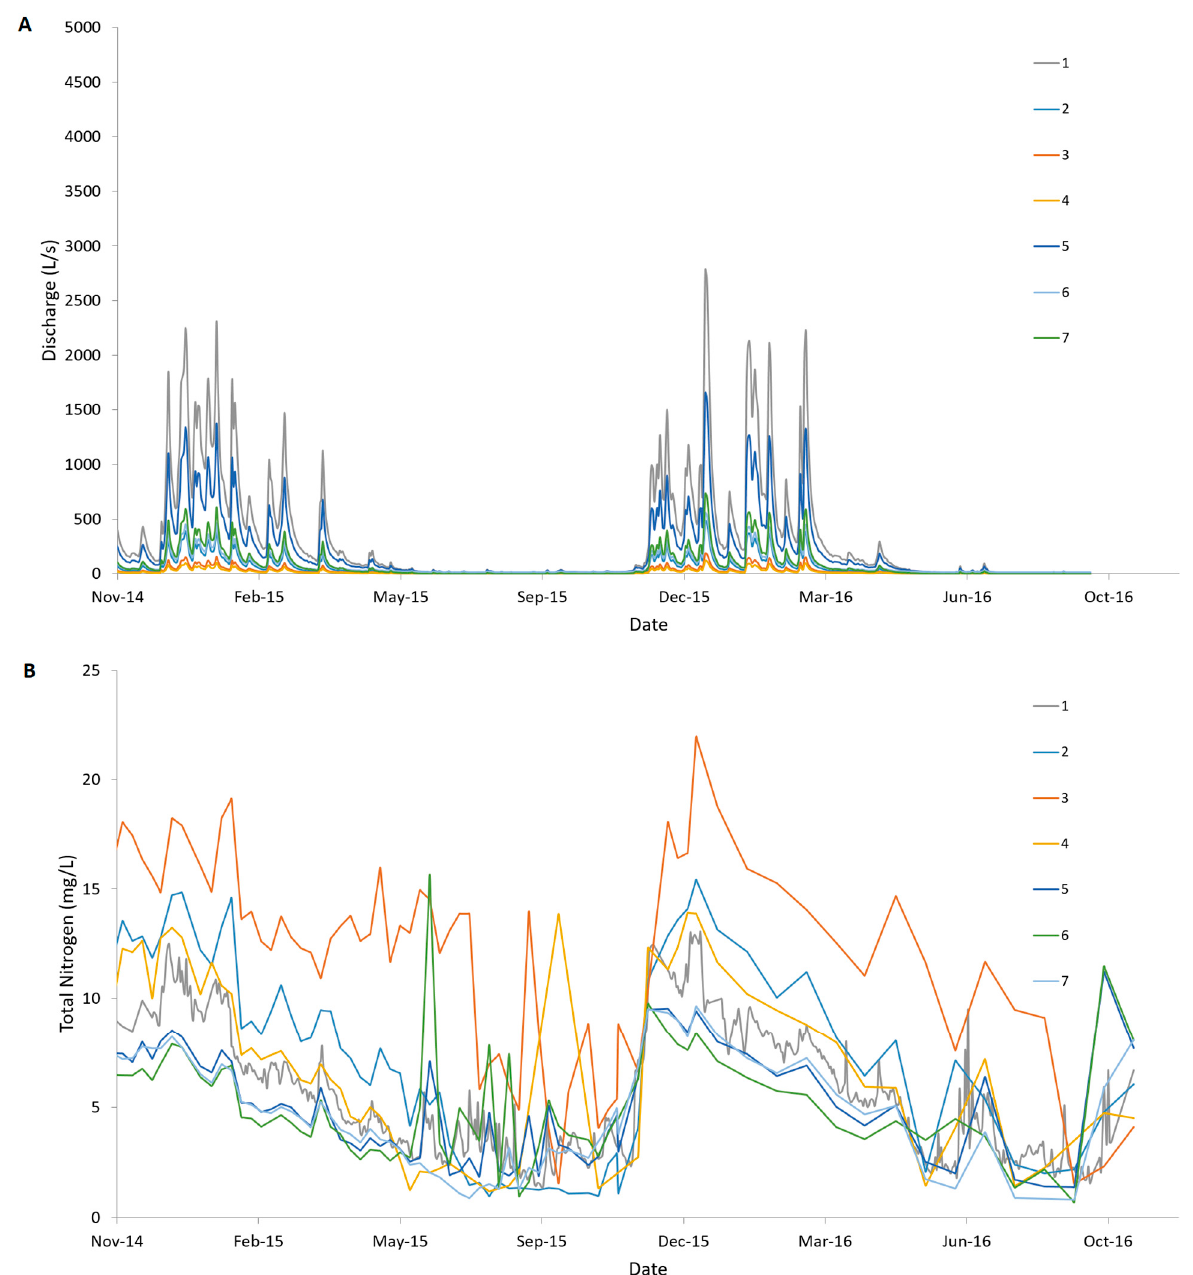
Figure A3. ( A ) Discharge measurements at the synchronous stations in the sub-catchments and at the main gauging station of Saltø catchment in the period 2014 to 2016. ( B ) TN concentrations measured at the synchronous stations in the sub-catchment and at the main gauging station of Jegstrup catchment in the period 2014 to 2016. Linear interpolation was used between weekly and fortnightly grab sample measurements to obtain daily measurements at the synchronous stations.